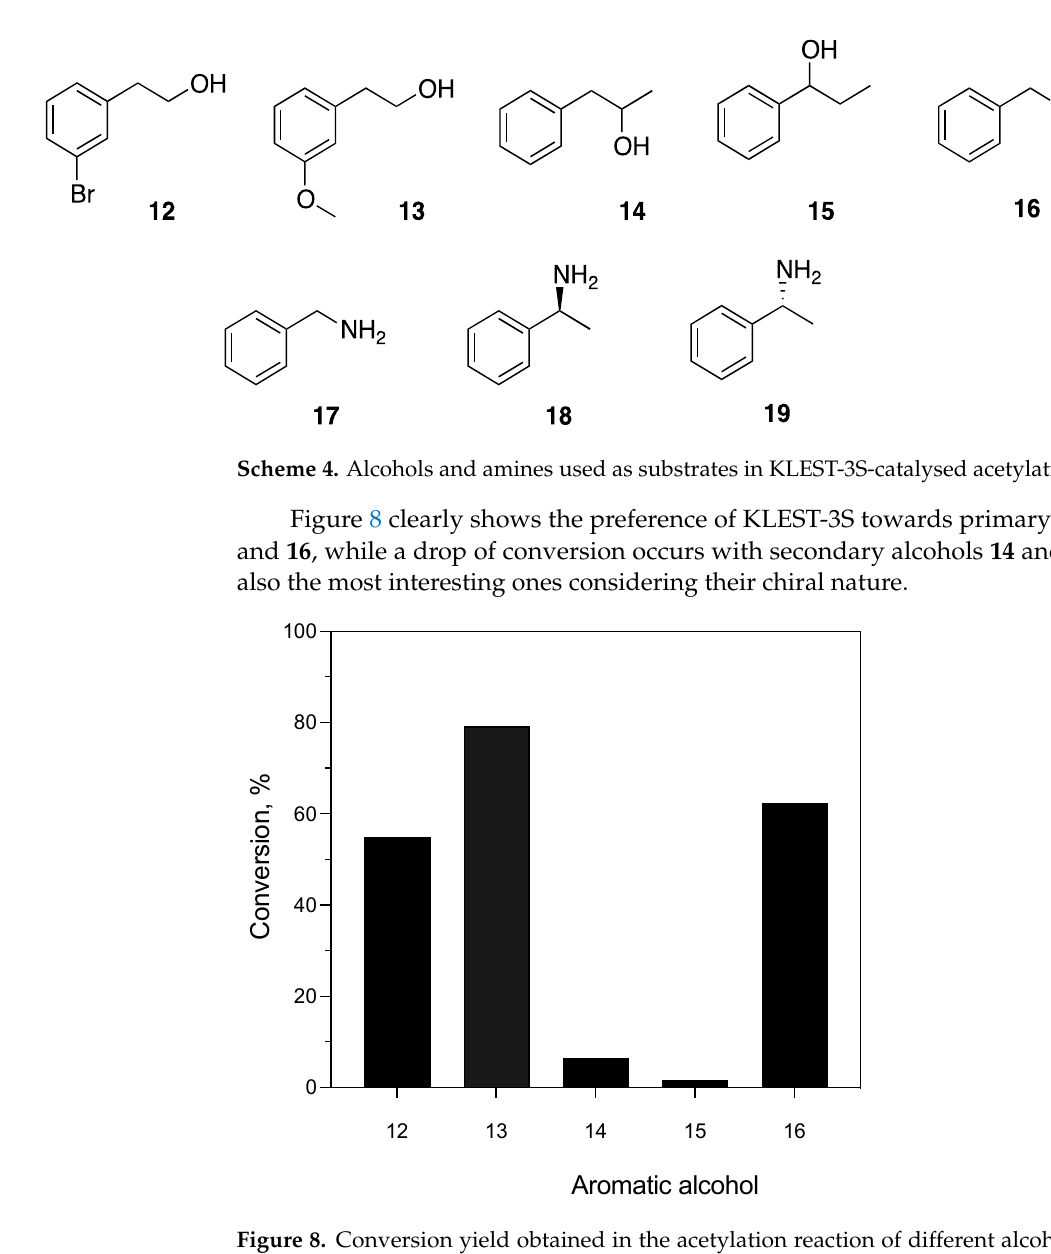
Figure 8. Conversion yield obtained in the acetylation reaction of different alcohols in a biphasic system vinyl acetate: buffer phosphate (2:1). KLEST-3S, 8.5 U, 24 h reaction time, 100 mg CaCO 3 , 65 °C, 30 mg of each alcohol.